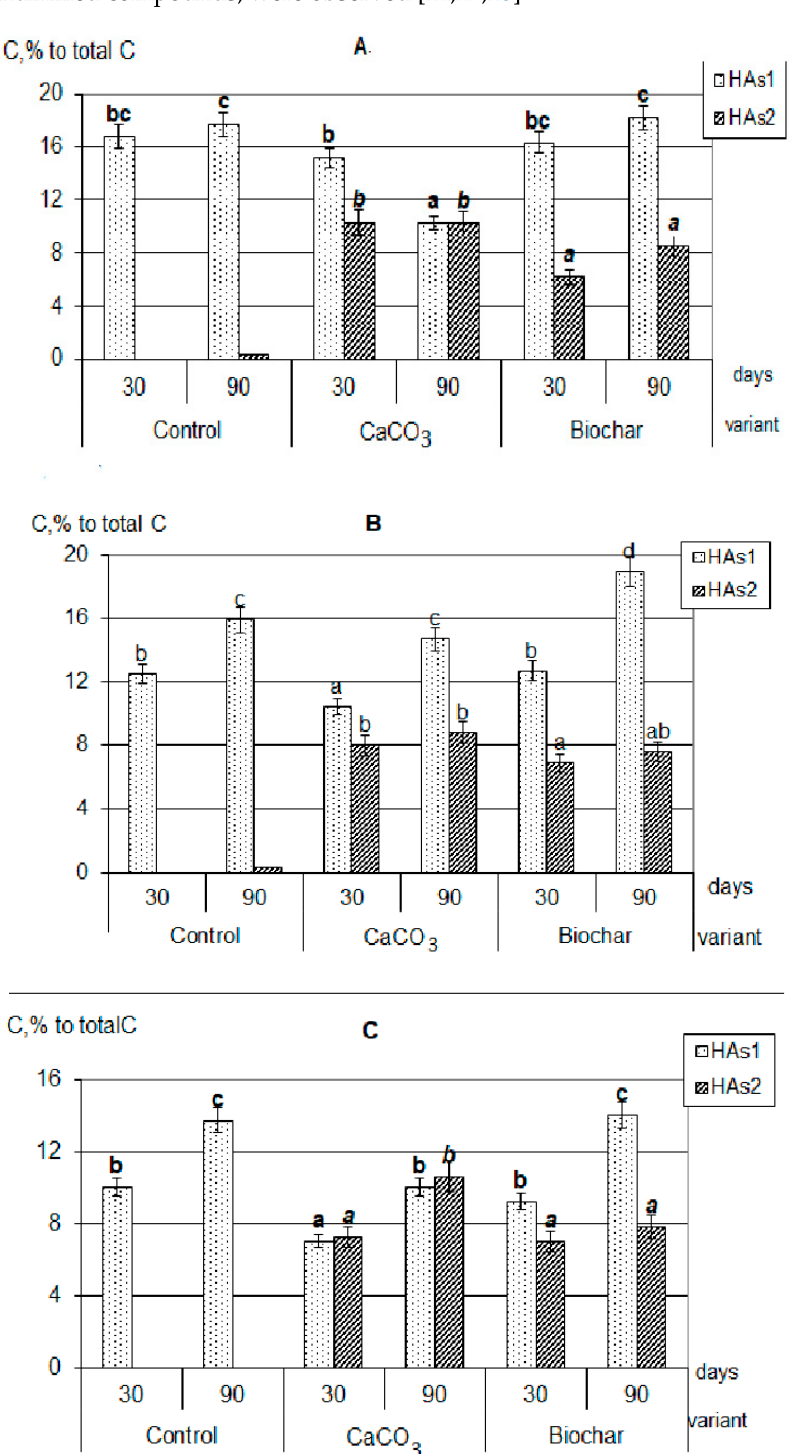
Figure 2. Composition of newly formed humic acids formed during the decomposition of plant residues, C, % to total C: ( A )—clover, ( B )—rye, ( C )—oats (the same small letters mean no significant differences between the values at the level of significance p < 0.05, n = 4; one-way ANOVA, Student-Newman-Keuls test).